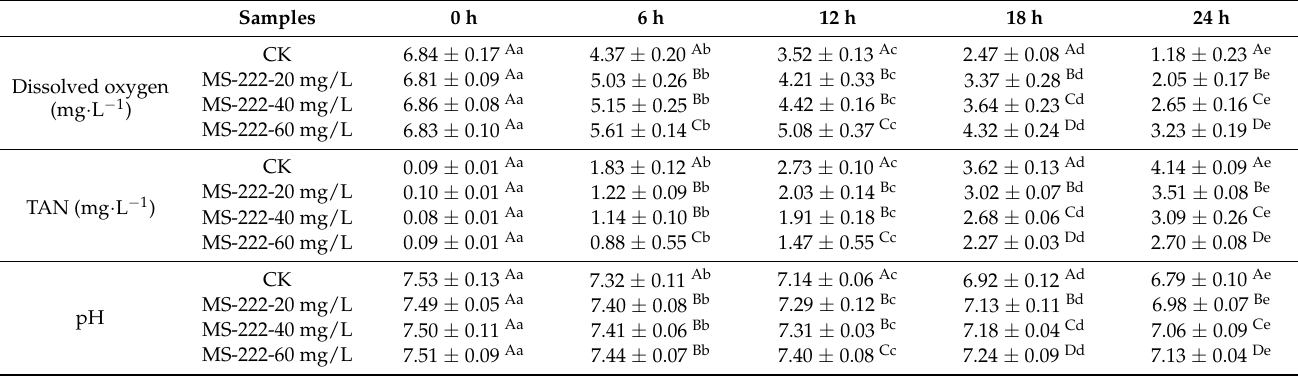
Table 1. Water quality parameters during simulated